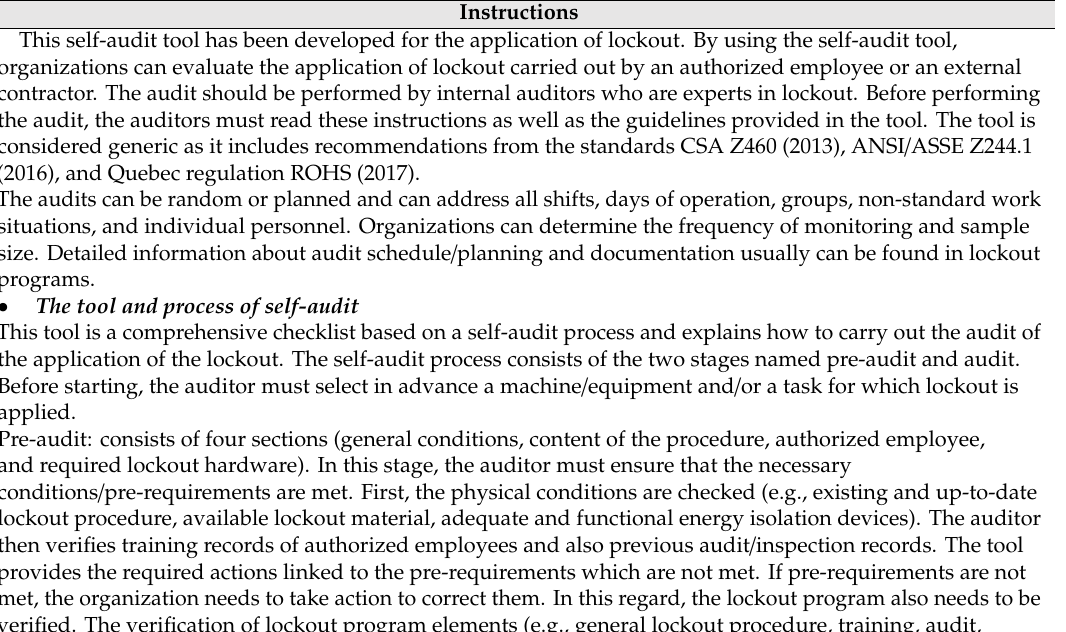
Table A 1. Self-audit tool: Instructions and General information.